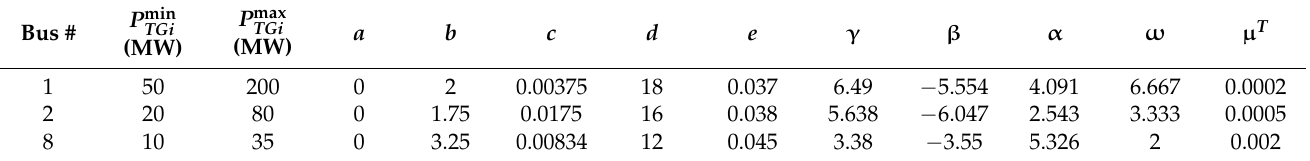
Table 2. Details of thermal generators cost and emission